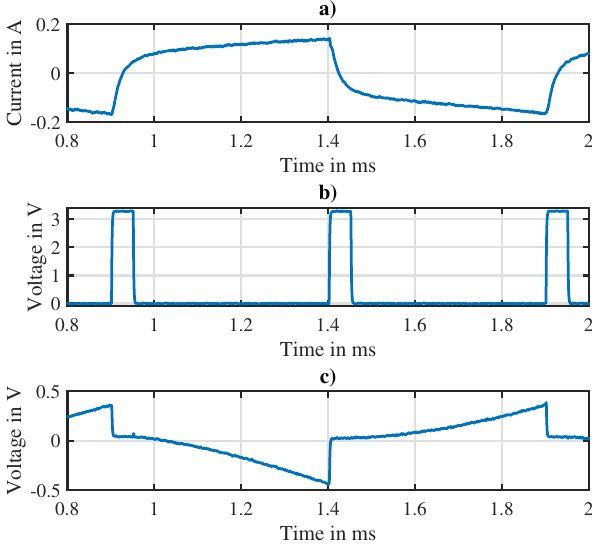
Figure 12. Experimental measurements, ( a ) current ripple induced by the bipolar PWM voltage, ( b ) trigger signal necessary for the IDIM implementation, ( c ) corresponding output of the analog